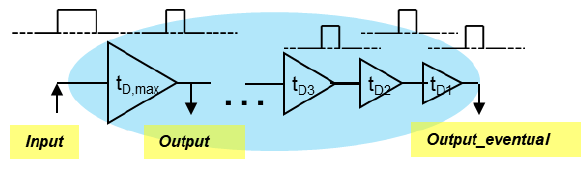
Figure 7. Minimum pulse width characterization in Liberty timing library